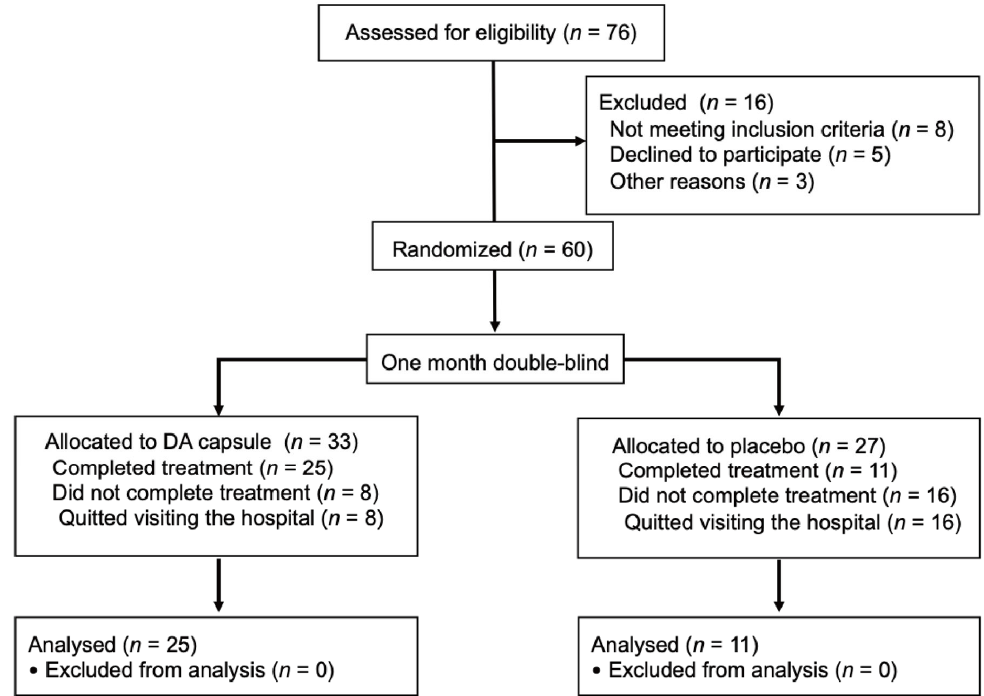
Figure 6. Flow Diagram of hyperuricemia subjects and interventions.